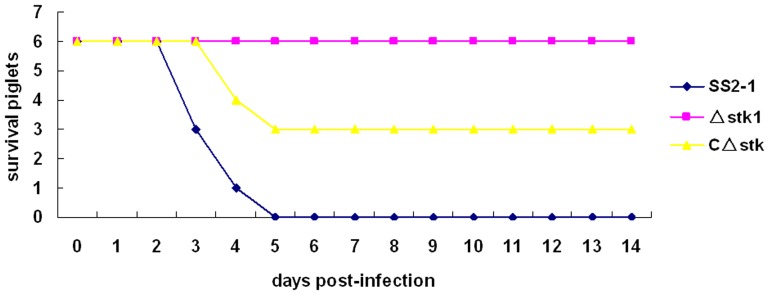
Survival curves for piglets in experiment infection.Six piglets in each group were intravenously inoculated with 5×106 CFU/piglet of SS2-1, Δstk and CΔstk, respectively. Two piglets were inoculated with PBS and served as a control.